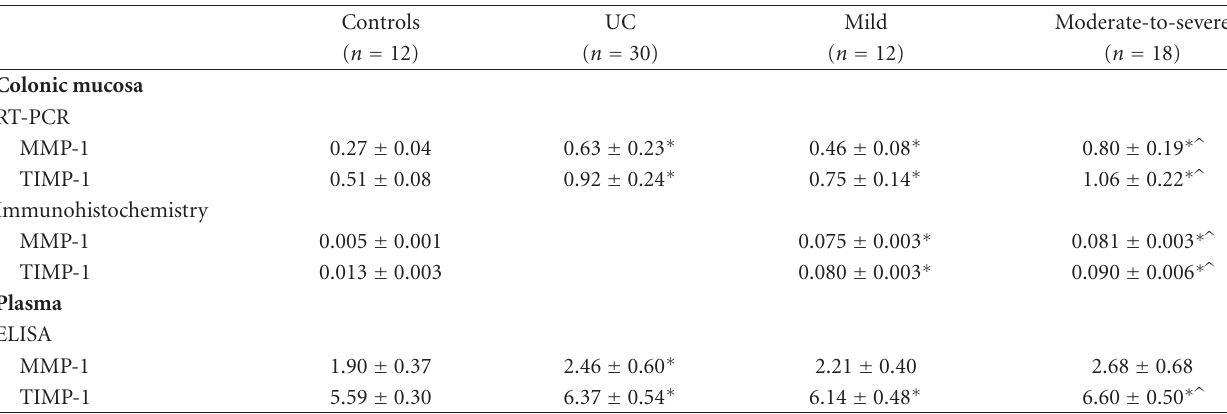
Table 1: MMP-1 levels in colonic mucosa and plasma.